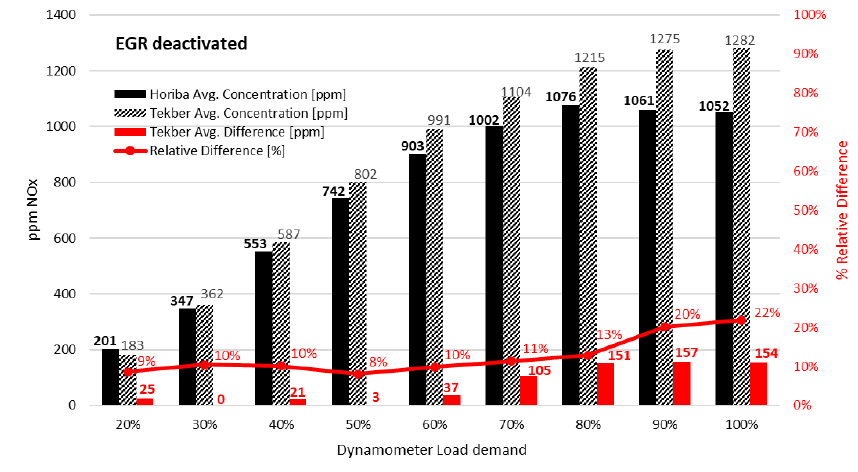
Figure 10. Differences between Tekber and Horiba results according to the load demand without EGR.